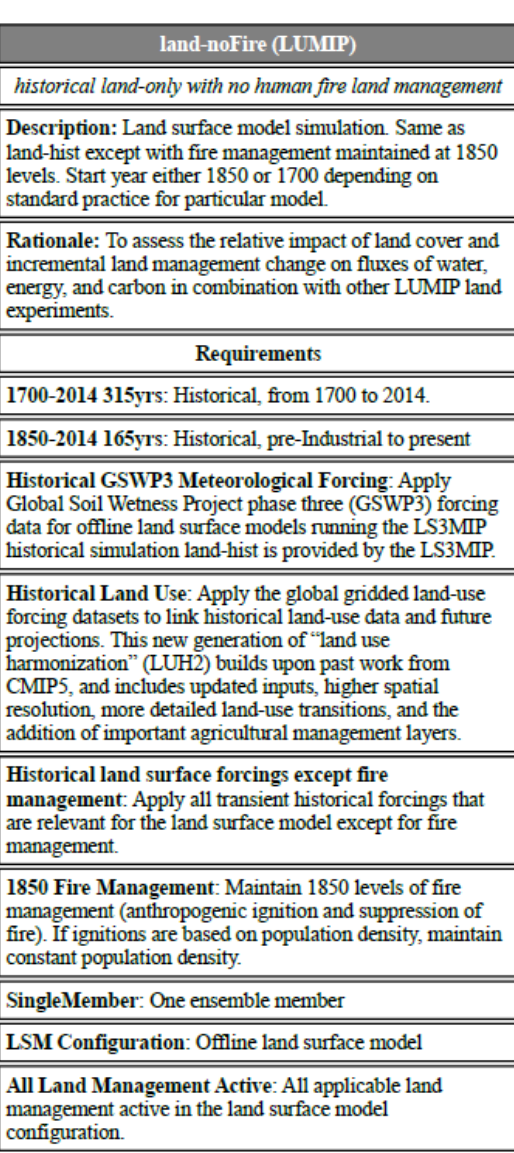
Table A3. The “Increase Cirrus Sedimentation Velocity” forcing constraint is very precise about the change to be made to “Add a local variable that replaces (in all locations where temperature is colder than 235K) the ice mass mixing ratio in the calcula- tion of the sedimentation velocity with a value that is eight times the original ice mass mixing ratio”. See